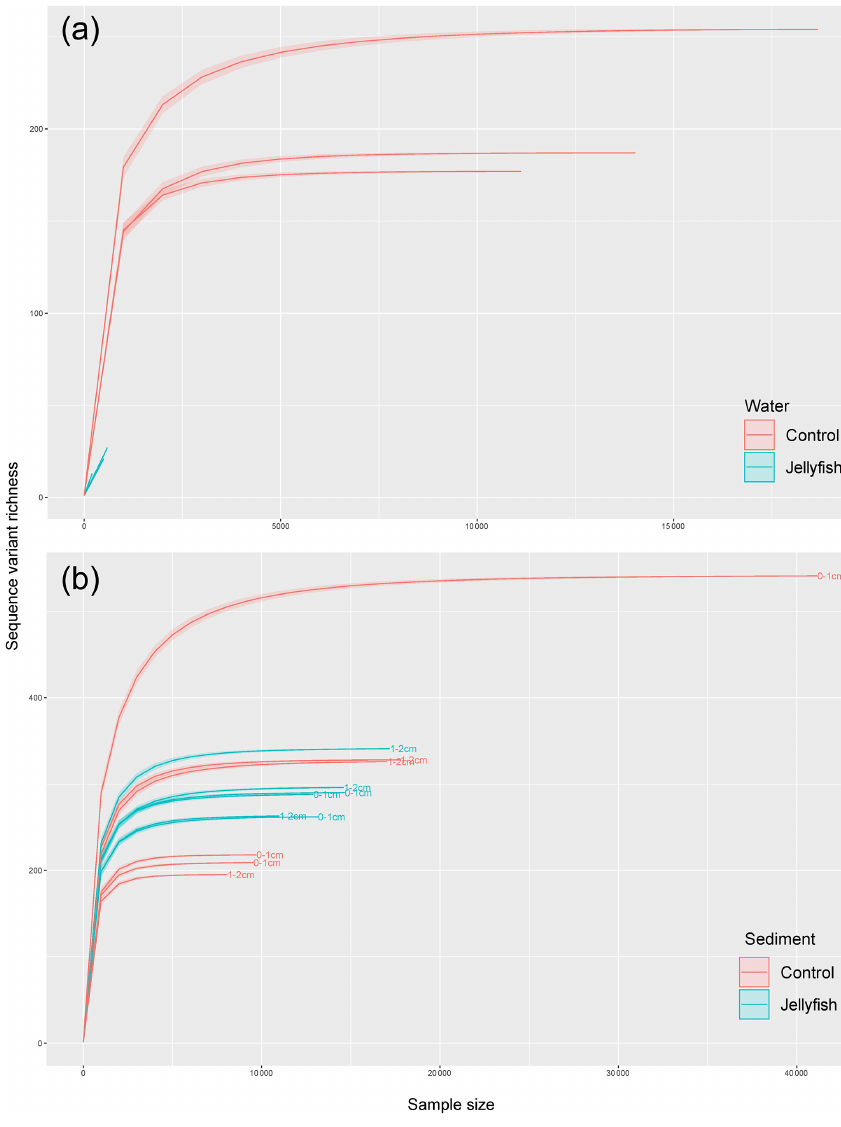
Figure C4. Rarefaction curves of observed 18S rRNA sequence variants retrieved from the seawater (a) and sediment (b) samples.